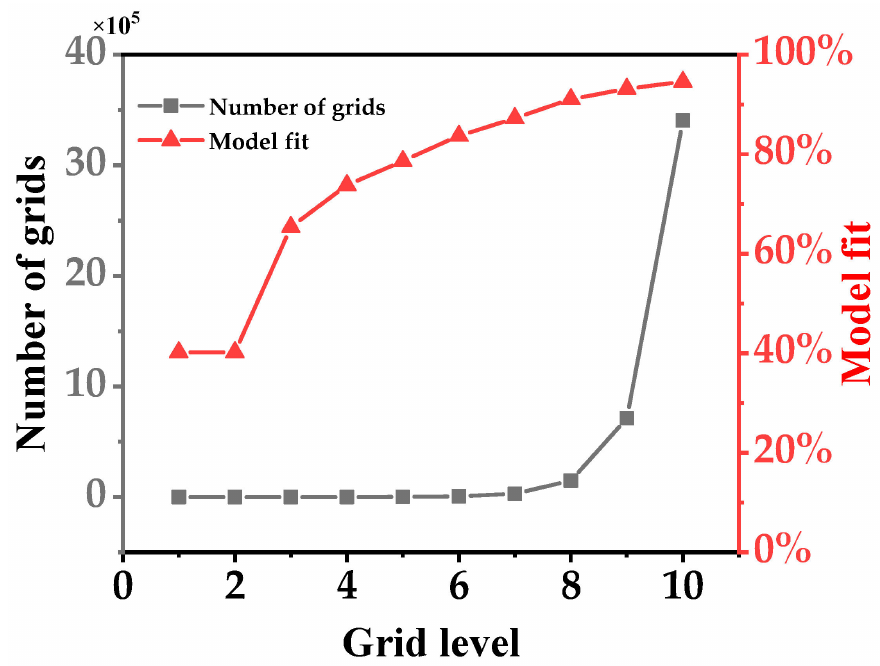
Figure 18. Variation trend of grid number and model